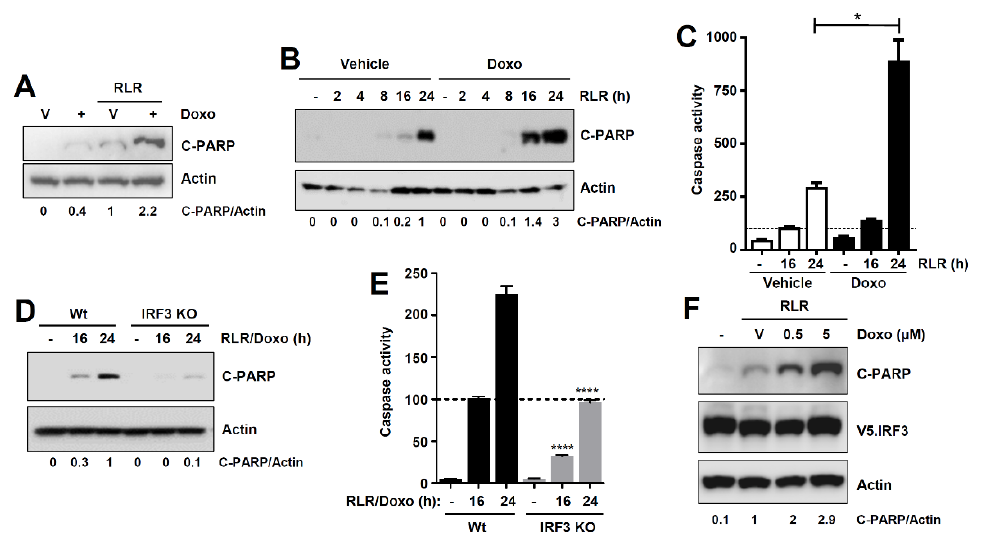
Figure 5. Doxorubicin is a novel activator of the RIPA branch of IRF3. ( A ) MDA-MB-453 cells were transfected with polyI:C in the absence or the presence of doxorubicin for 16 hrs, when C-PARP was analyzed by immunoblot. ( B ) MDA-MB-453 cells were transfected with polyI:C (RLR) in the absence or the presence of doxorubicin for the indicated times, when C-PARP was measured by immunoblot. ( C ) MDA-MB-453 cells were transfected with polyI:C (RLR, as in A) in the absence or presence of doxorubicin for the indicated times, when caspase-3 activity was measured. ( D ) Wt and IRF3 − / − (KO) HT1080 cells were transfected with polyI:C (RLR) in the presence of doxorubicin for the indicated times, when C-PARP was analyzed by immunoblot. ( E ) Wt and IRF3 − / − (KO) HT1080 cells were transfected with polyI:C (RLR) in the presence of doxorubicin, and caspase-3 activity was measured at the indicated times post-RLR stimulation. ( F ) IRF3 − / − cells complemented with IRF3 K10 mutant were transfected with polyI:C (RLR) in the absence or the presence of doxorubicin (at the indicated doses) and C-PARP was measured by immunoblot 24 h post-RLR. Vehicle, DMSO treatment, * indicates p < 0.05, **** p < 0.0001.